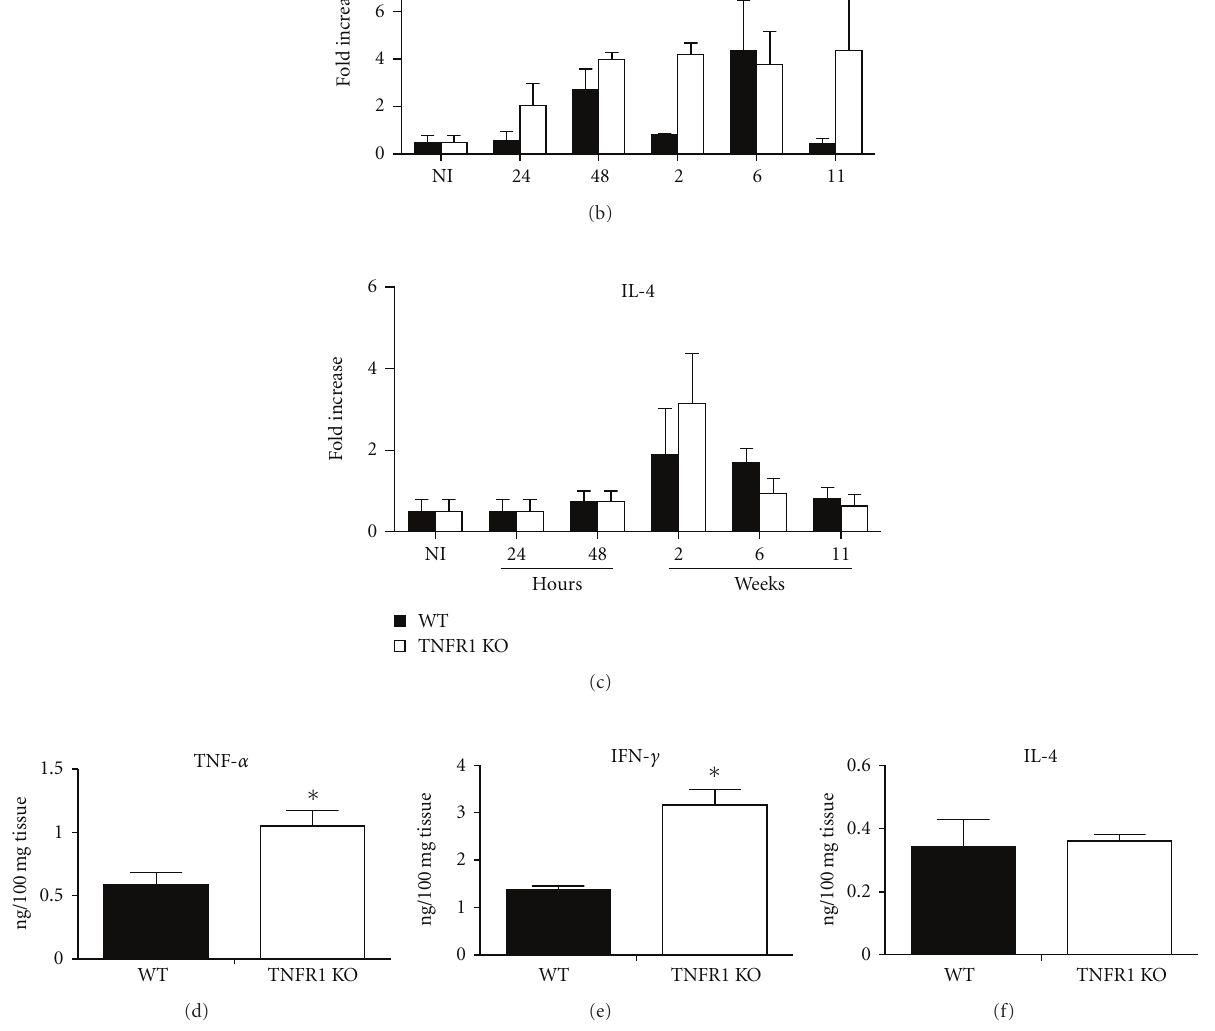
Figure 3: TNF- α , IFN- γ , and IL-4 in lesions from WT and TNFR1 KO mice infected with L. major . Mice were infected in both footpads with L. major (1 × 10 6 ). At 24 and 48h and at 2, 6, and 11 weeks after infection, mice were killed, lesions were harvested, and RT-PCR reactions performed for cytokines. At 15 weeks protein was assayed by ELISA. (a–c) Fold increase in TNF- α , IFN- γ , and IL-4 mRNA, obtained by densitometry of bands in gels, as described in Section 2. (d–f) TNF- α , IFN- γ , and IL-4 protein was determined by ELISA 15 weeks after infection. Data shown are from one experiment representative of two indenpendently performed ones, with four mice per group. ∗ P < 0 .